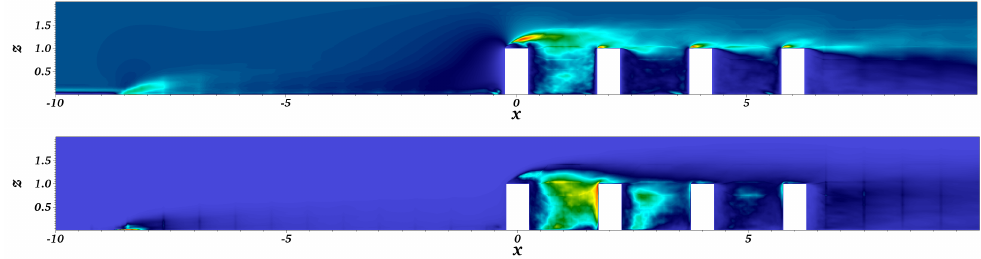
Figure 5. ( Top ) Streamwise normal Reynolds stress u 2 rms , where colors range from (dark blue) 0 to (dark red) 0.2. ( Bottom ) Square of the rms spanwise velocity fluctuations v 2 rms , where colors range from (dark blue) 0 to (dark red) 0.25. The y = 0 plane is